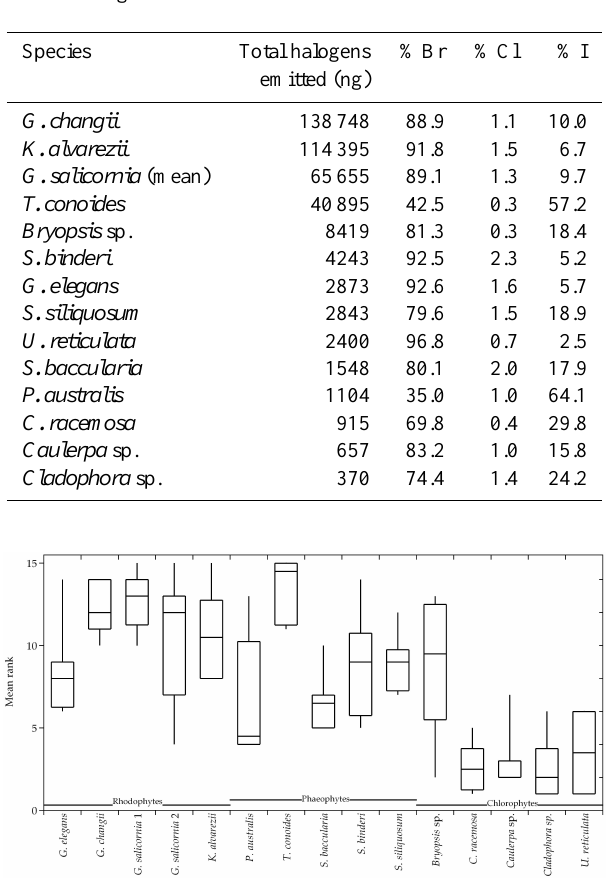
Table 4. Changes in mean “production rank” when calculating pro- duction using fresh or dry weight. Species are ordered in increasing percentage